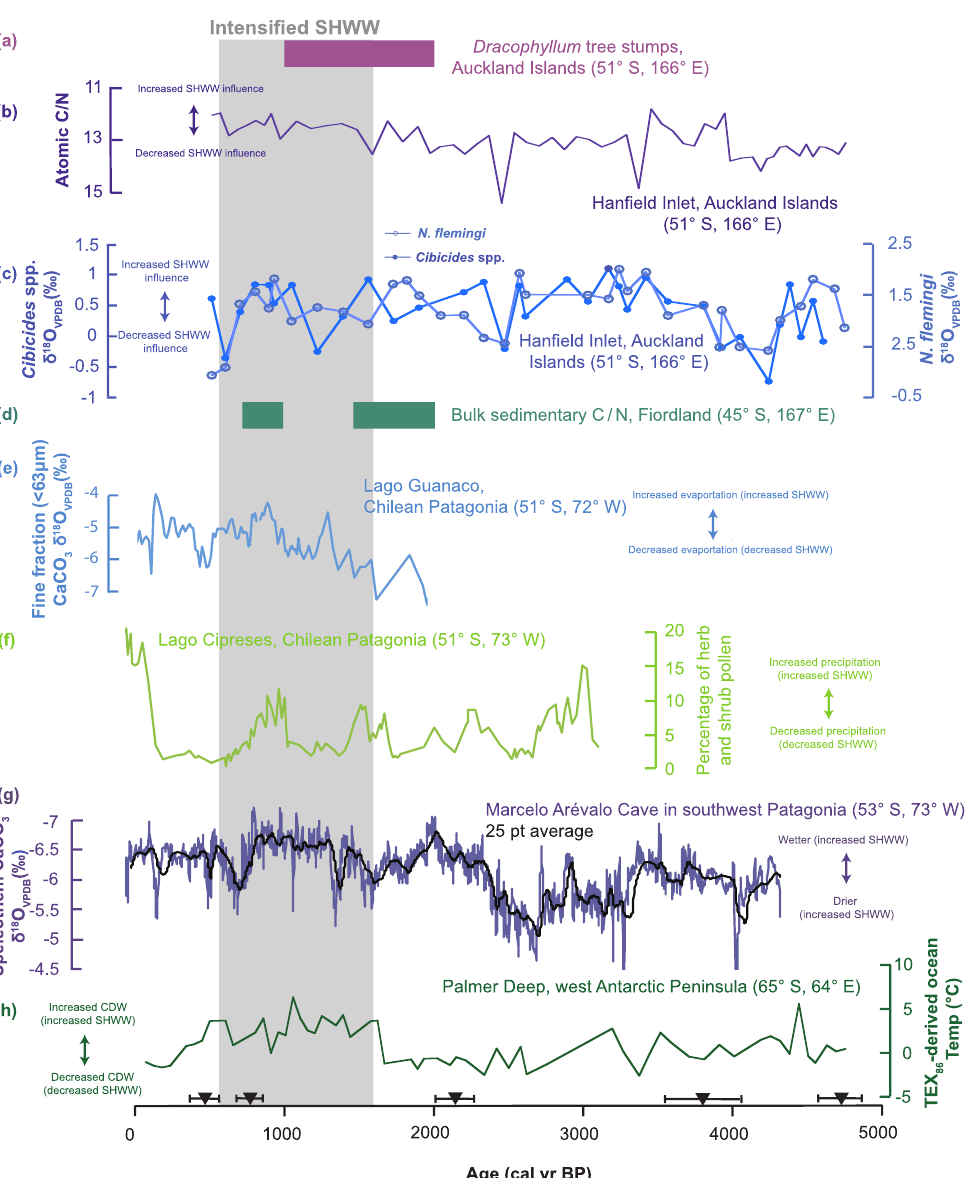
Figure 9. Compilation of Southern Hemisphere palaeoclimate records illustrating SHWW variability during the middle and late Holocene. Horizontal coloured bars indicate periods of intensified westerly winds and the vertical grey bar represents late Holocene intensification of the winds in several areas. Black triangles along the x axis represent the median probability ages with calibration error for 36P4. (a) Tree-line reconstruction using Dracophyllum tree stumps from the Auckland Islands (Turney et al., 2016b). (b) Bulk sedimentary C / N from Hanfield Inlet, Auckland Islands. (c) Benthic foraminifer δ 18 O ( Cibicides spp. and N. flemingi ) from Hanfield Inlet, Auckland Islands. (d) Bulk sedimentary atomic C / N from Fiordland, New Zealand (Knudson et al., 2011). (e) Fine fraction (<63µm) biogenic carbonate δ 18 O from Lago Guanaco, Chilean Patagonia (Moy et al., 2009). (f) Pollen record from Lago Cipreses, Chilean Patagonia (Moreno et al., 2014). (g) Stalagmite carbonate δ 18 O from Marcelo Arévalo Cave in southwest Patagonia (Schimpf et al., 2011). (h) TEX 86 -derived upper ocean temperatures (0–200m) from the Palmer Deep, western Antarctic Peninsula (Shevenell et al.,